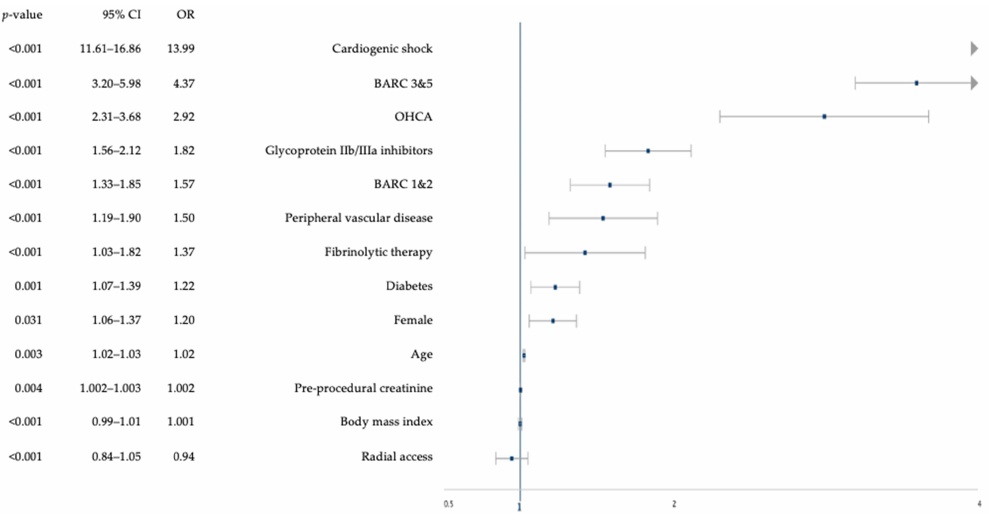
Figure 1. Independent predictors of cumulative in-hospital and 30-day MACCE. BARC = bleeding academic research consortium, CI = confidence interval, MACCE = major adverse cardiac and cerebrovascular events, OHCA = out-of-hospital cardiac arrest, OR = odds ratio.